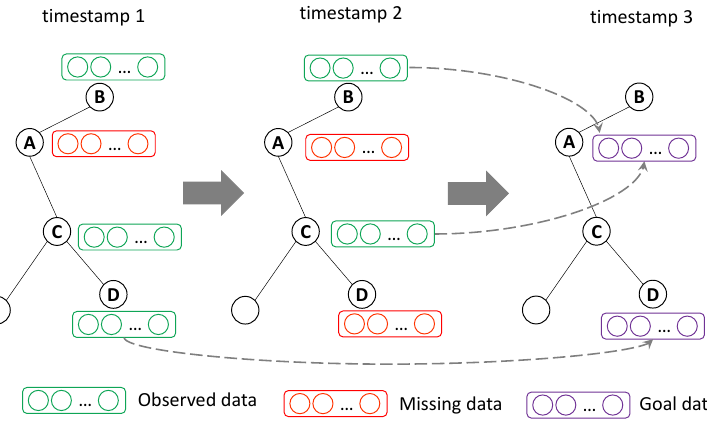
Figure 1. Illustration of the surrounding-aware individual emotion prediction